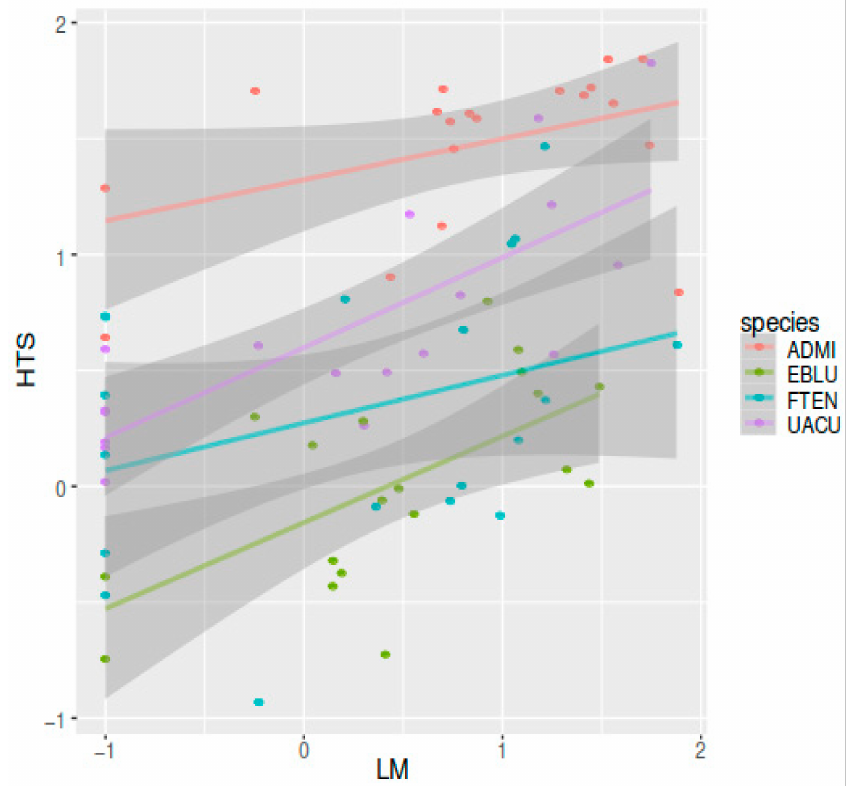
Figure 3. Relationship between the relative abundances obtained with microscopy (LM) and molec- ular (HTS) methods for the dominant taxa: Achnanthidium minutissimum (ADMI), Eunotia bilunaris (EBLU), Fragilaria tenera (FTEN) and Ulnaria acus (UACU) (note the log